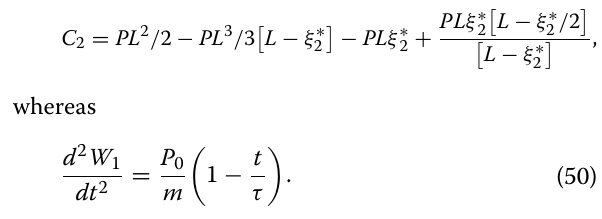
With the imposition of the triangular pulse load on the beam two plastic hinges are formed, Fig. 12, at a distance 0 . of ξ 1 from the root of the cantilever, and ξ